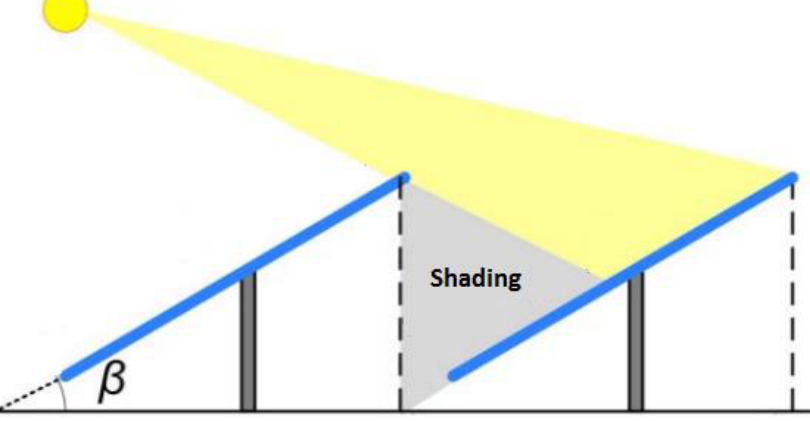
Figure 5. Parallel tilted PV modules facing sun and their shading caused by tilt angle.